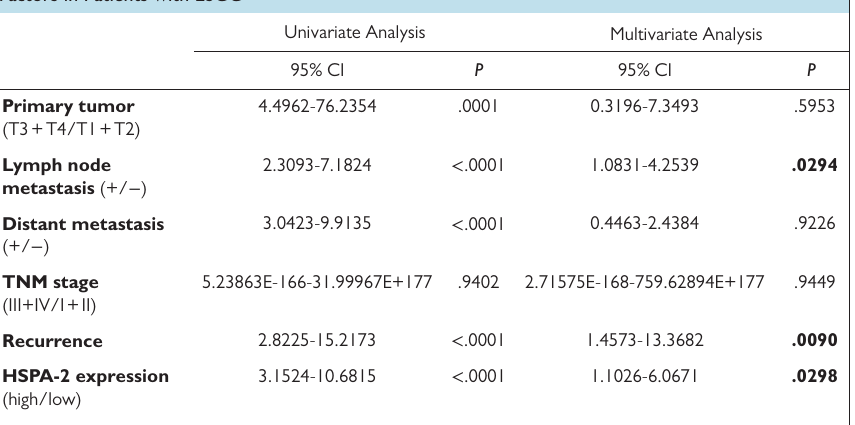
Figure 6. Kaplan–Meier estimate of survival in all patients according to heat shock-related 70-kDa protein 2 expression. Table 3. Univariate and Multivariate Cox Regression Analyses of the Most Important Prognostic Factors in Patients with LSCC